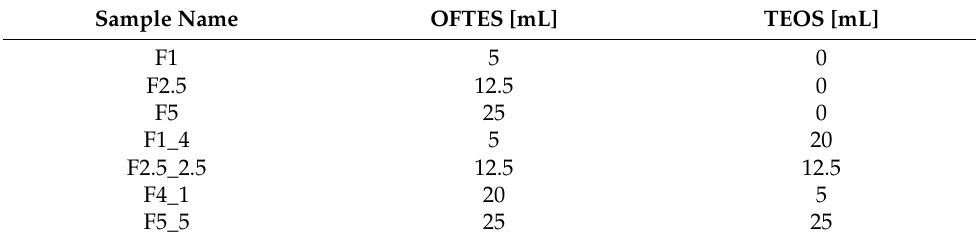
Table 1. Amounts of reagents used for the preparation of silane